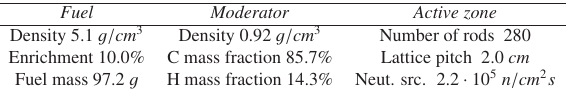
Figure 3: k e ff